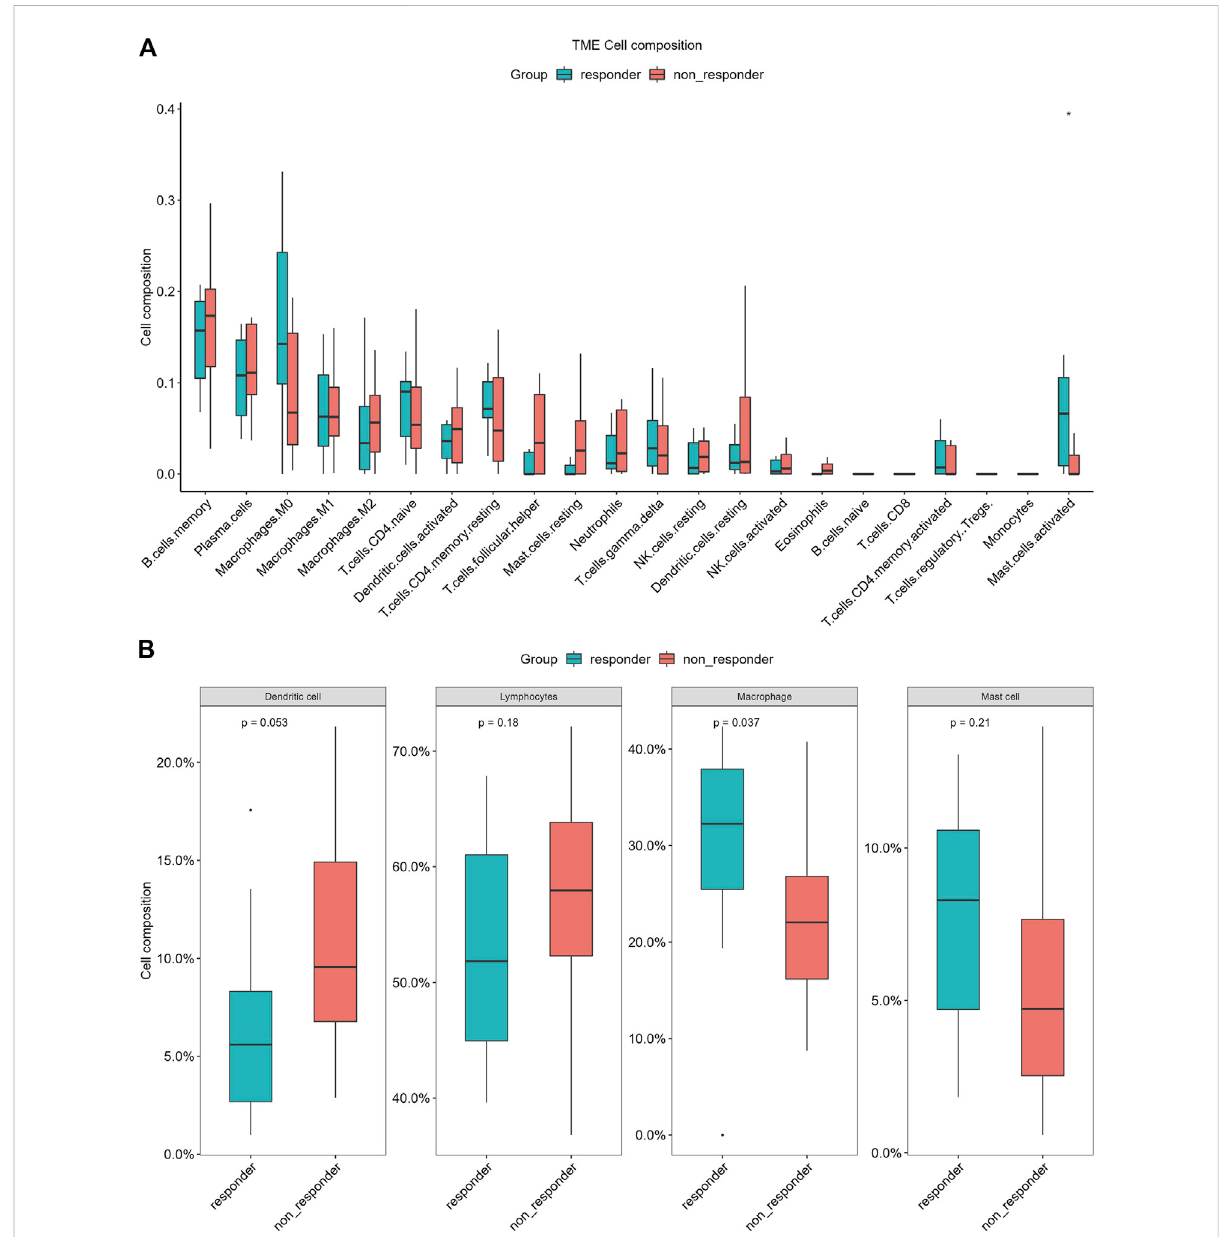
FIGURE 8 Differences of in fi ltrating immune cell types between the non-responder group and the responder group of CIBERSORT in GSE45670 cohort. (A) 22-classi fi cation method, (B) 4-classi fi cation